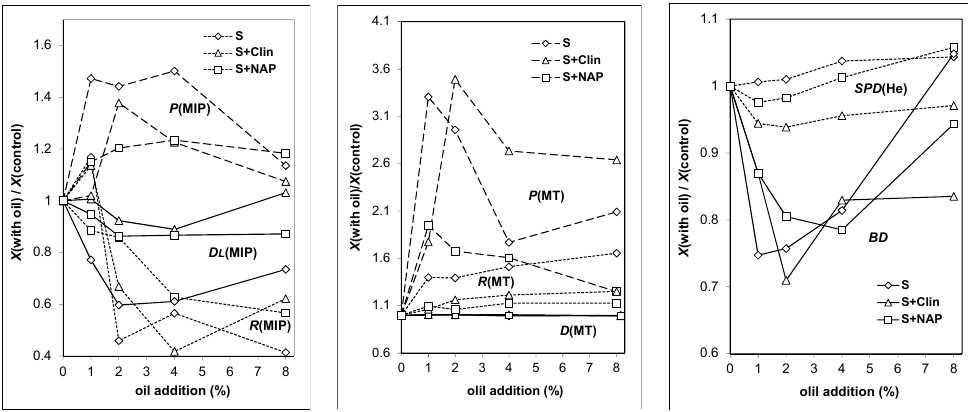
Figure 7. Relative changes in structural parameters of the LWAs with increasing oil content.